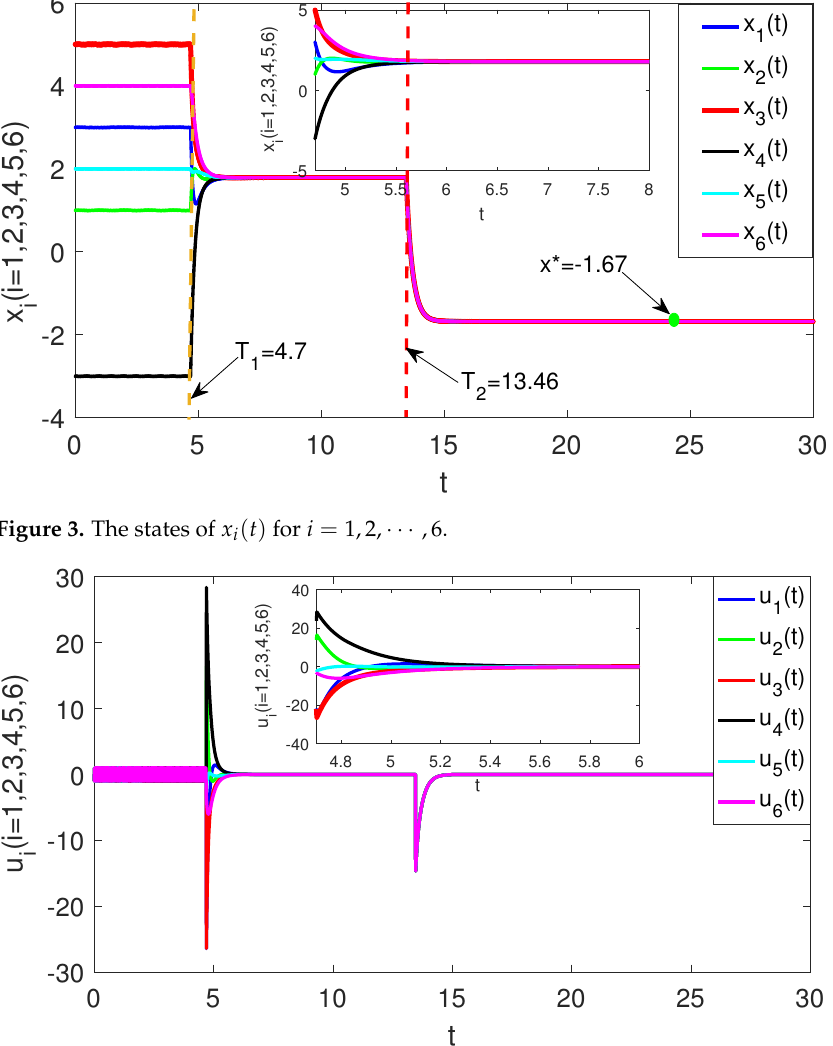
Figure 4. The evolution of control input u i ( t ) for i = 1,2, · · ·